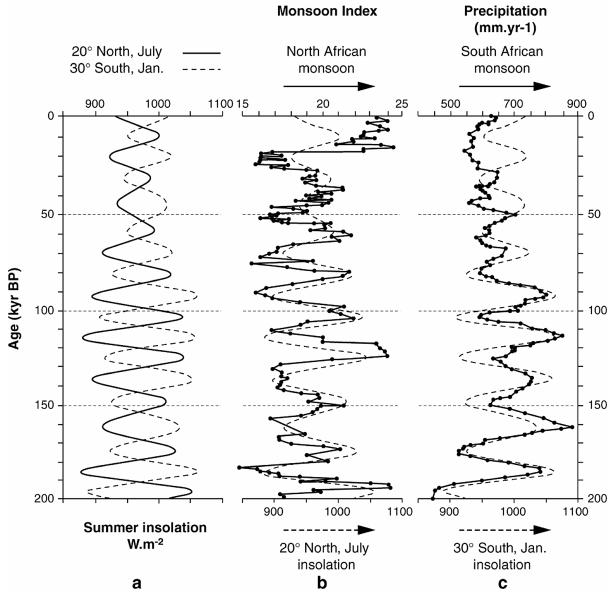
Figure 16. Comparison of (c) variations in southern monsoon pre- cipitation reconstructed from a 200ka sedimentary record from the Pretoria Saltpan, South Africa (Partridge et al., 1997), with (b) a monsoonal precipitation index at 203N based on fossil faunal as- semblage variations in deep-sea-sediment core RC24-07 (203N; McIntyre et al., 1989), and (a) changes in summer solar radiation in the northern and southern subtropics (Partridge et al.,